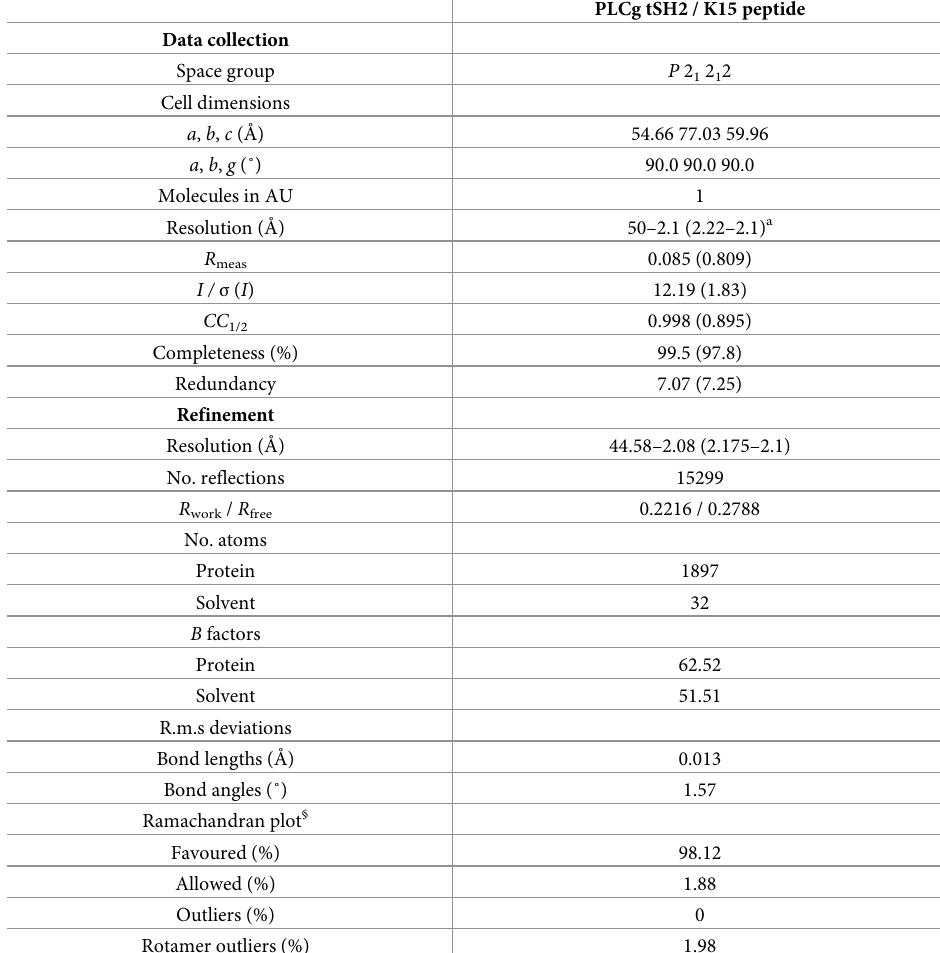
Table 1. Data collection, phasing and refinement